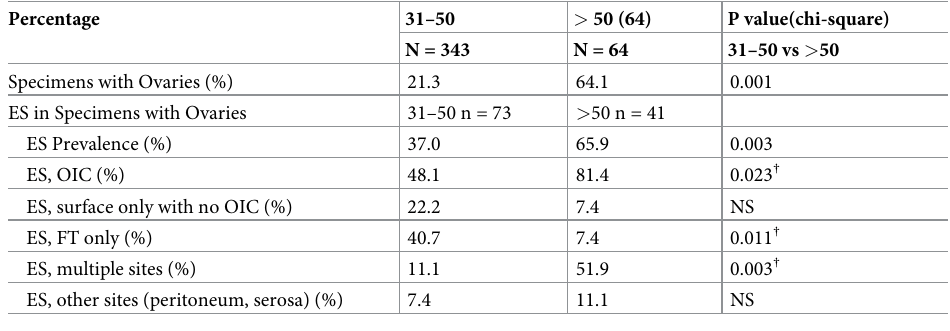
Table 4. Location of endosalpingial